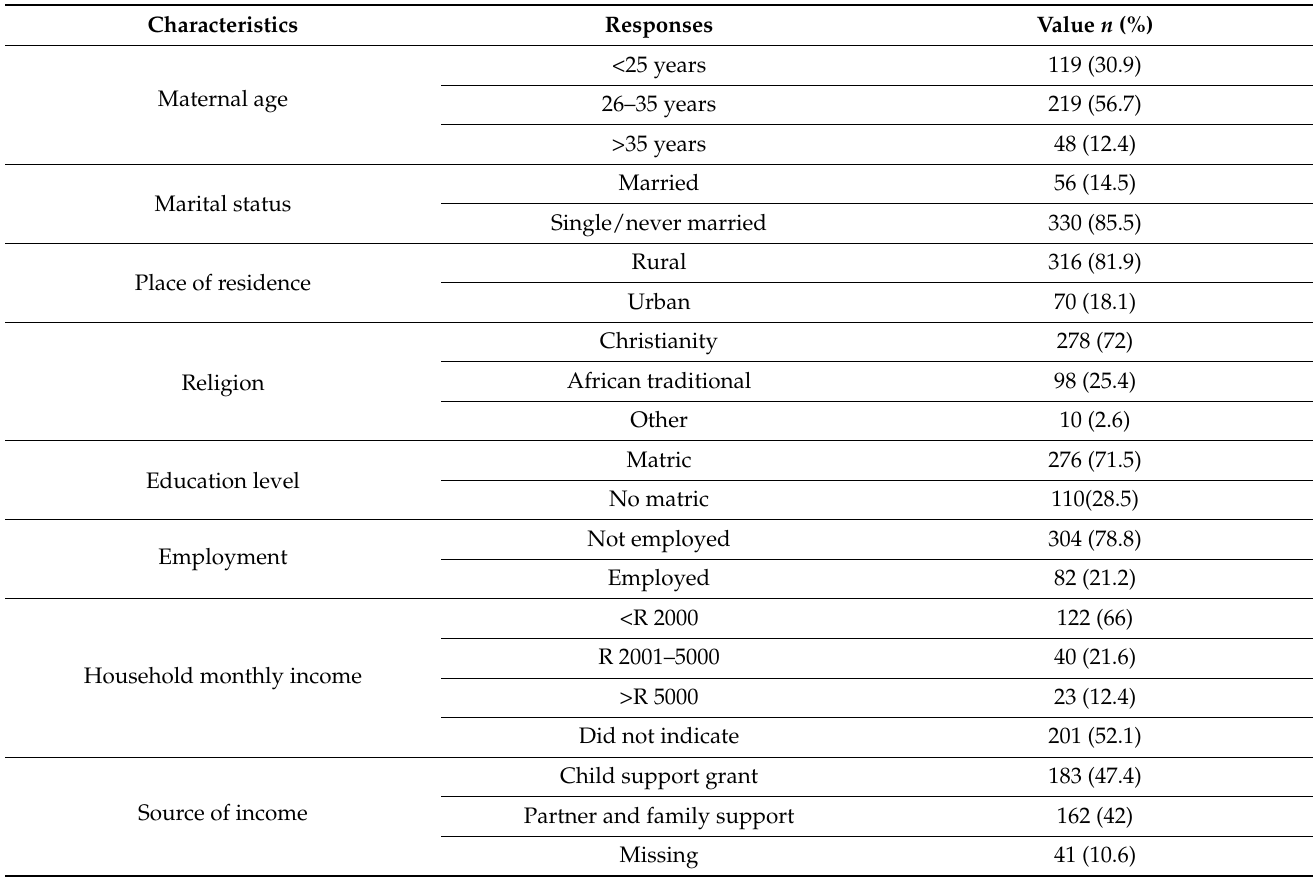
Table 1. Demographic characteristics of the sample ( n = 386).